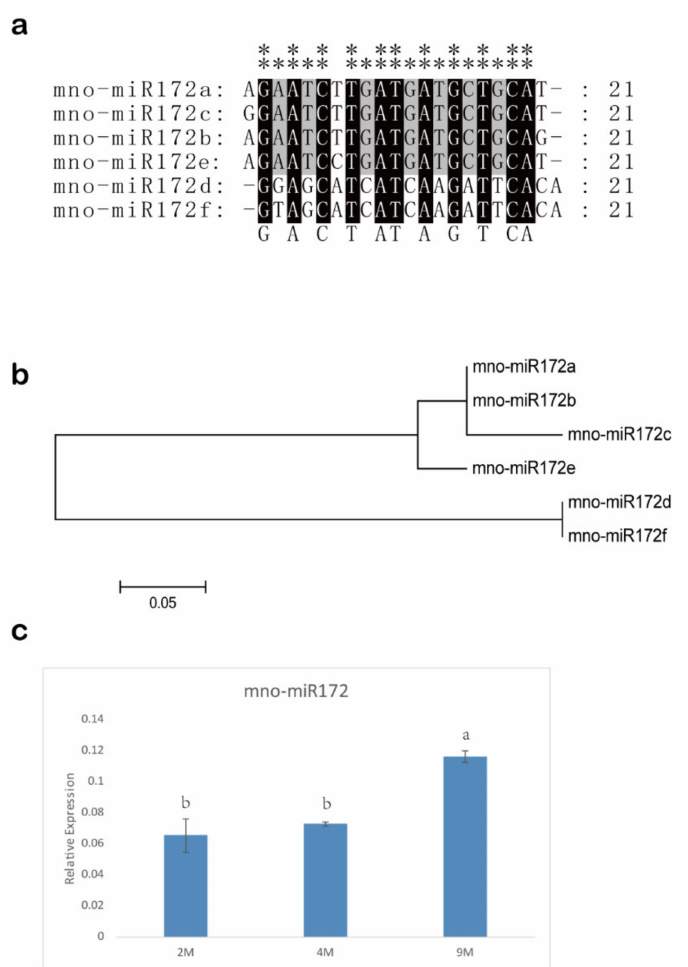
Figure 5. miR172 in mulberry. ( a ) Sequence alignment of miR1172 in mulberry. “**” shows highly conserved sites with no base difference, “*” indicates low conservation sites with two base differences. ( b ) Neighbor-joining (NJ) phylogenetic tree of miR172 in mulberry. One thousand bootstrap replicates were used. ( c ) The expression profile of miR172 in leaves at 2 months (2 M), 4 months (4 M) and 9 months (9 M) in mulberry. Values represent the mean ± SD of three biological replicates and were statistically analyzed (one-way ANOVA test): p <